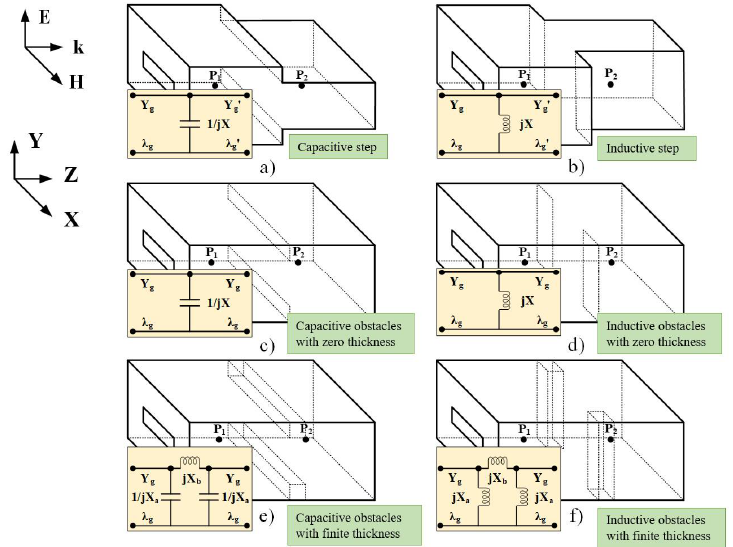
Figure 6. Six common types of irregular structures. ( a ) Capacitive step, ( b ) Inductive step, ( c ) Capaci-